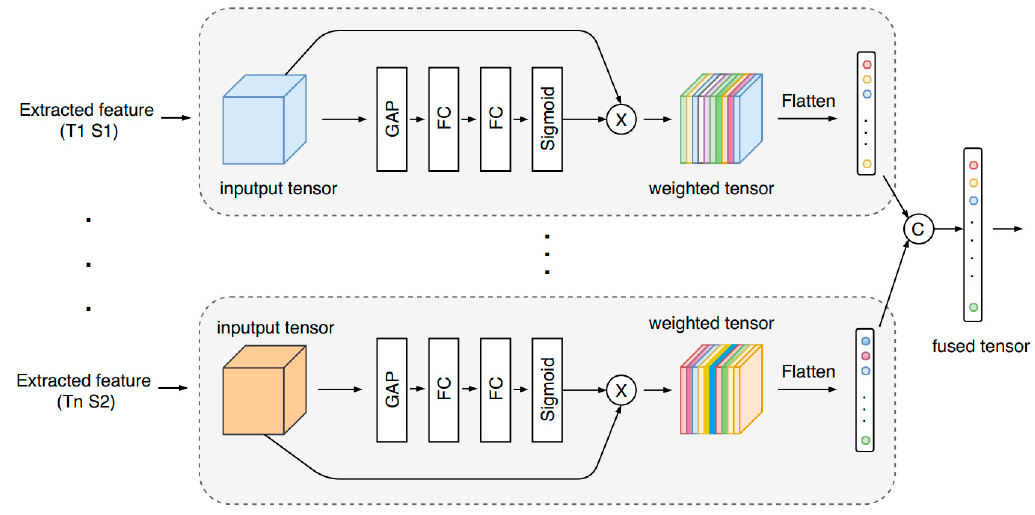
Figure 7. Structure of the adaptive feature fusion module. GAP: global average pooling; FC: fully connected; ×: element-wise multiplication; and C: concatenation.